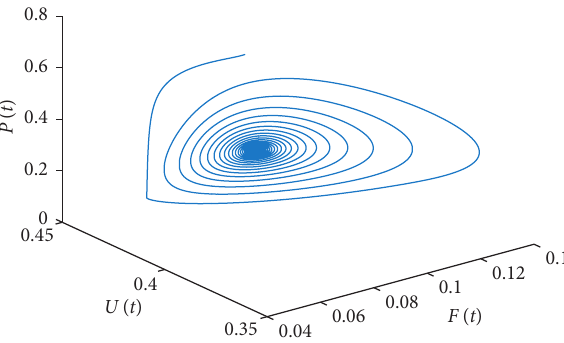
Figure 7: Portrait diagram of land model (30) with ϕ � 0 . 90, � 728 . 403. τ � 700 < τ 0